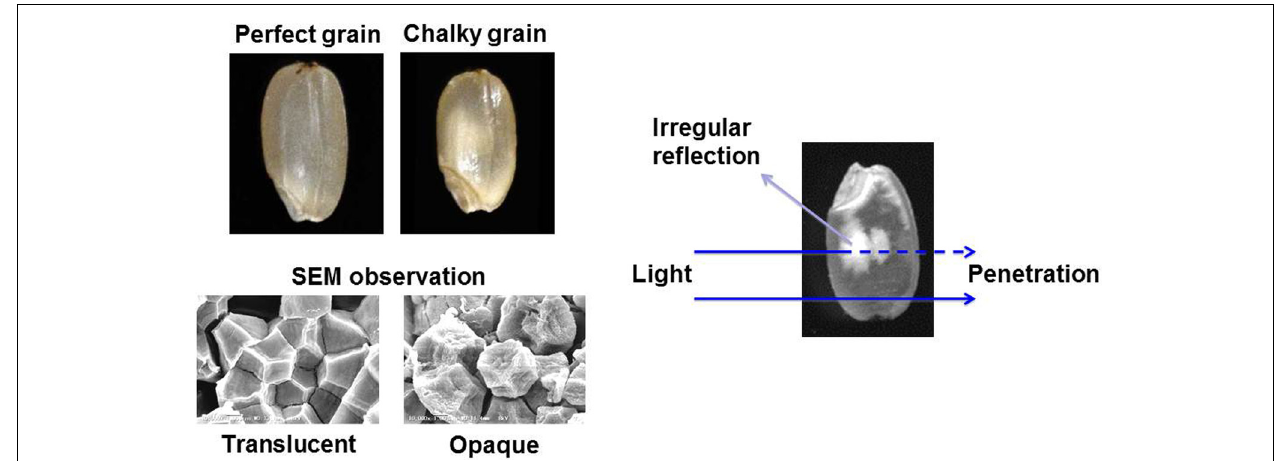
FIGURE 1 | Perfect and chalky grains of rice. Bars: 3.33 μ